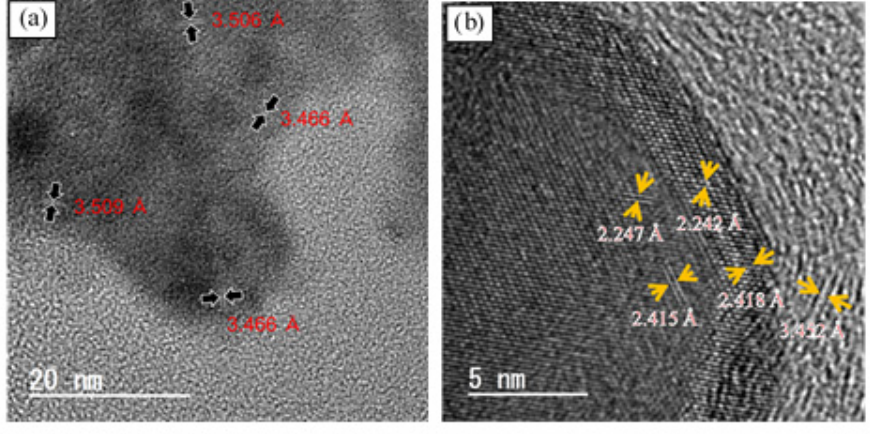
Figure 14. HRTEM images of titanium dioxide ( a ) and carbon-titanium dioxide ( b )